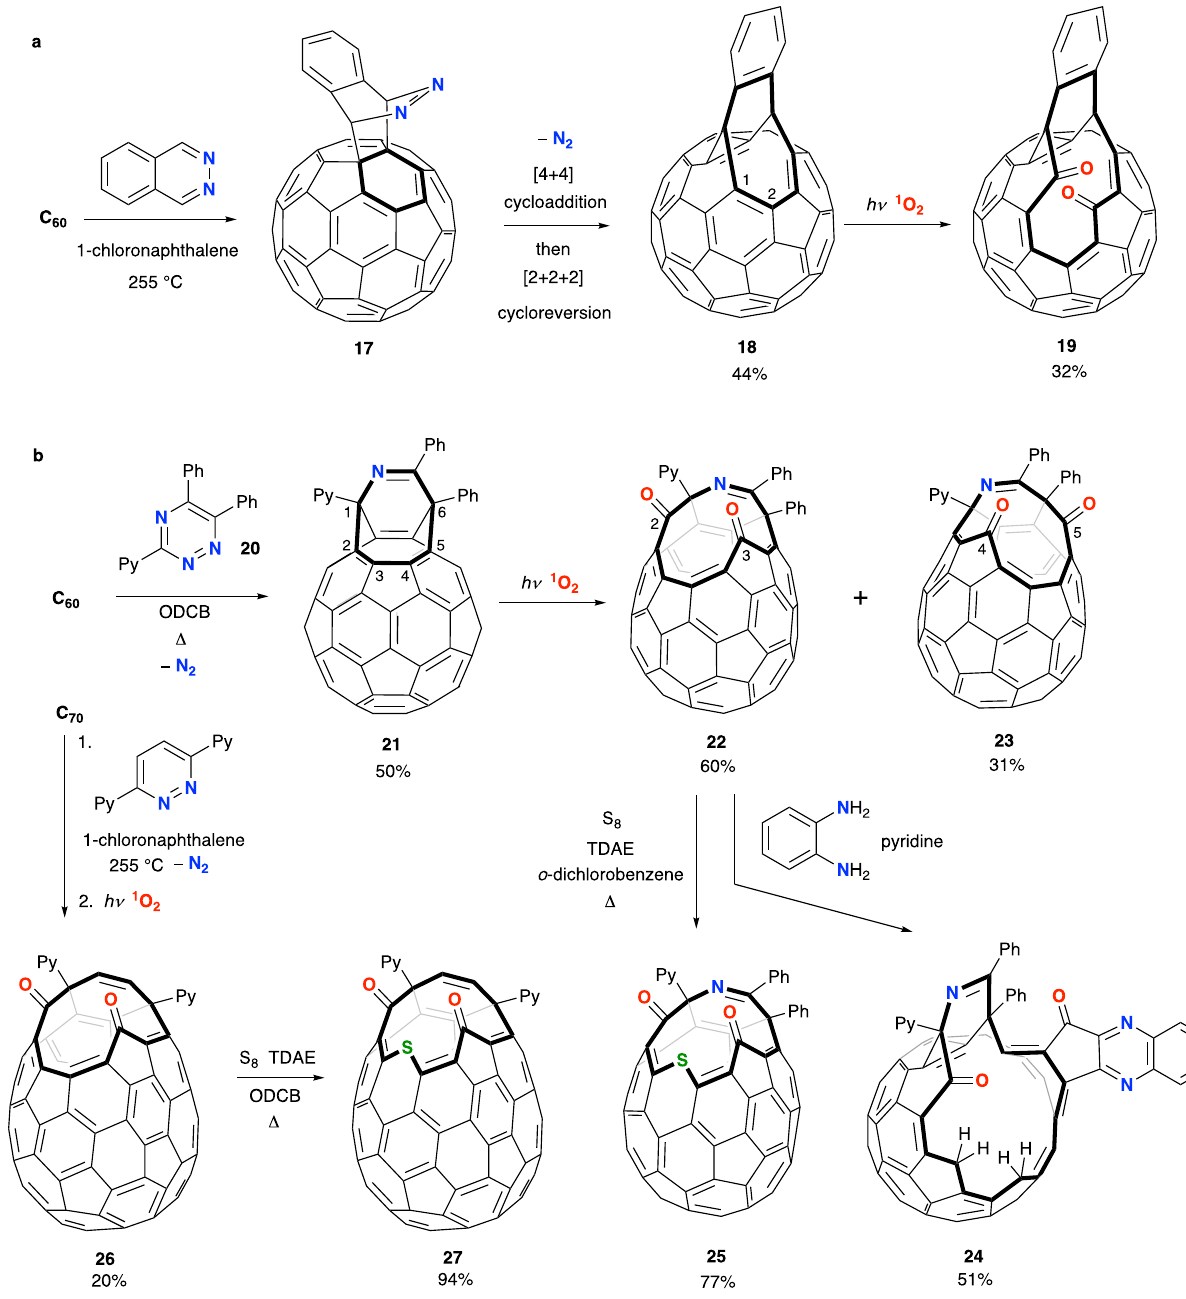
Fig. 3 Open-fullerenes prepared from reaction of C 60 with pyridazine derivatives. a An open-fullerene ( 18 ) with the core ethene-bridged structure of 8 is obtained in one-pot from C 60 , and undergoes regioselective oxidative cleavage. b Cycloaddition of C 60/70 with a substituted triazine or pyridazine. Abbreviations: 2-pyridyl (Py), o -dichlorobenzene (ODCB), tetrakis(dimethylamino)ethylene